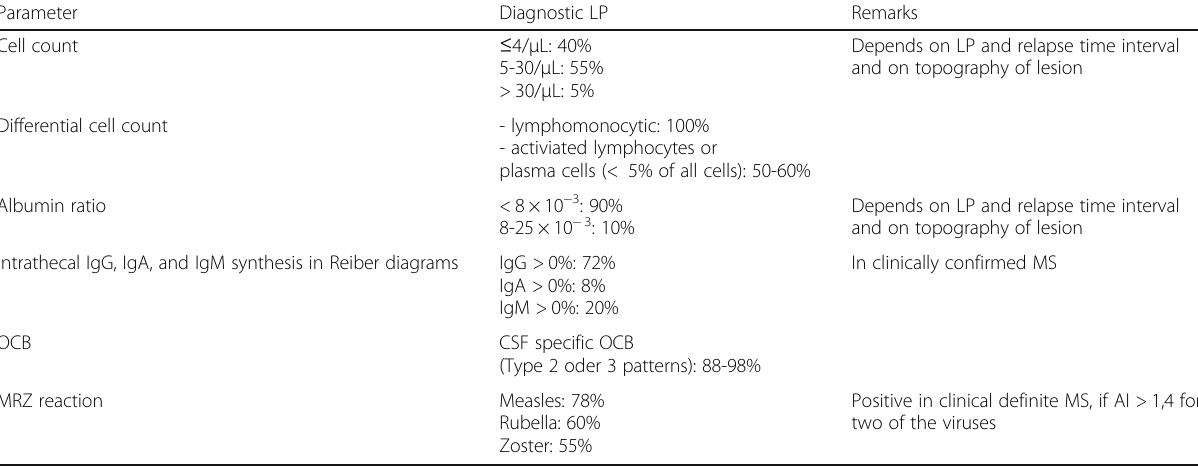
Table 12 Frequency of abnormal changes in routine CSF parameters in patients with multiple sclerosis [150]